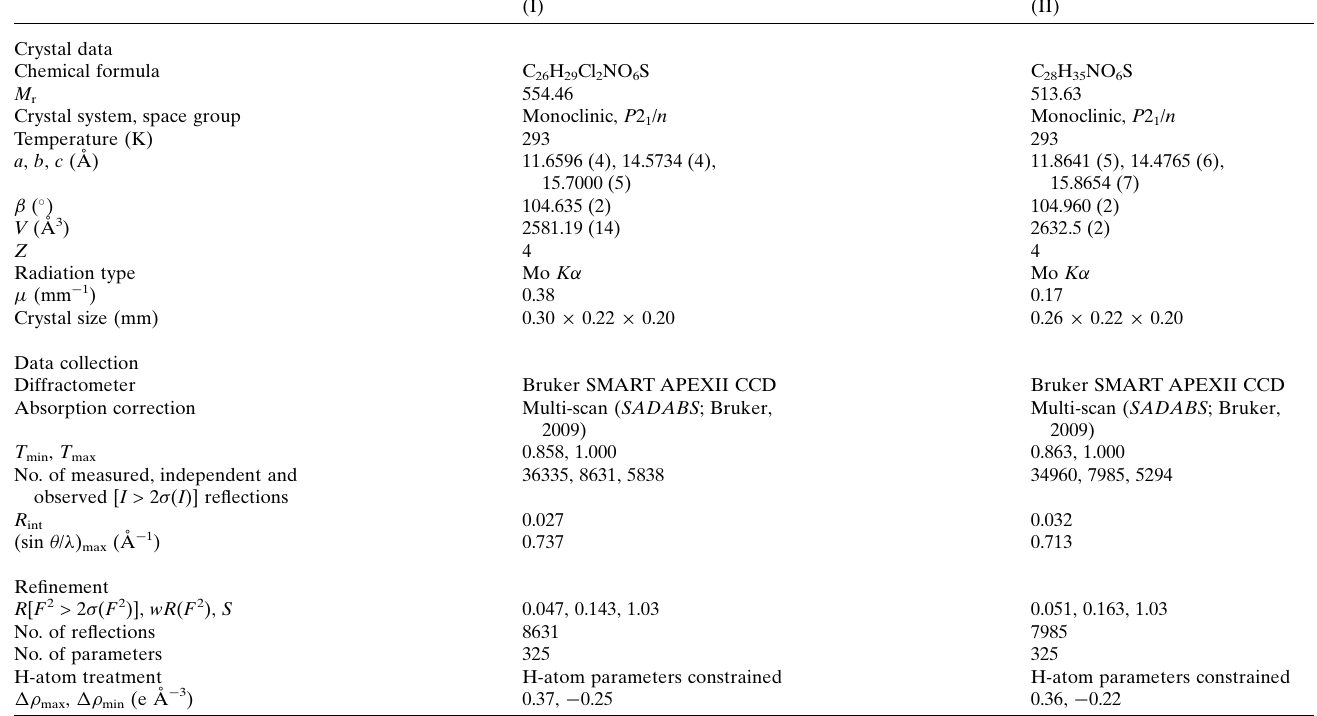
Table 3 Experimental details.